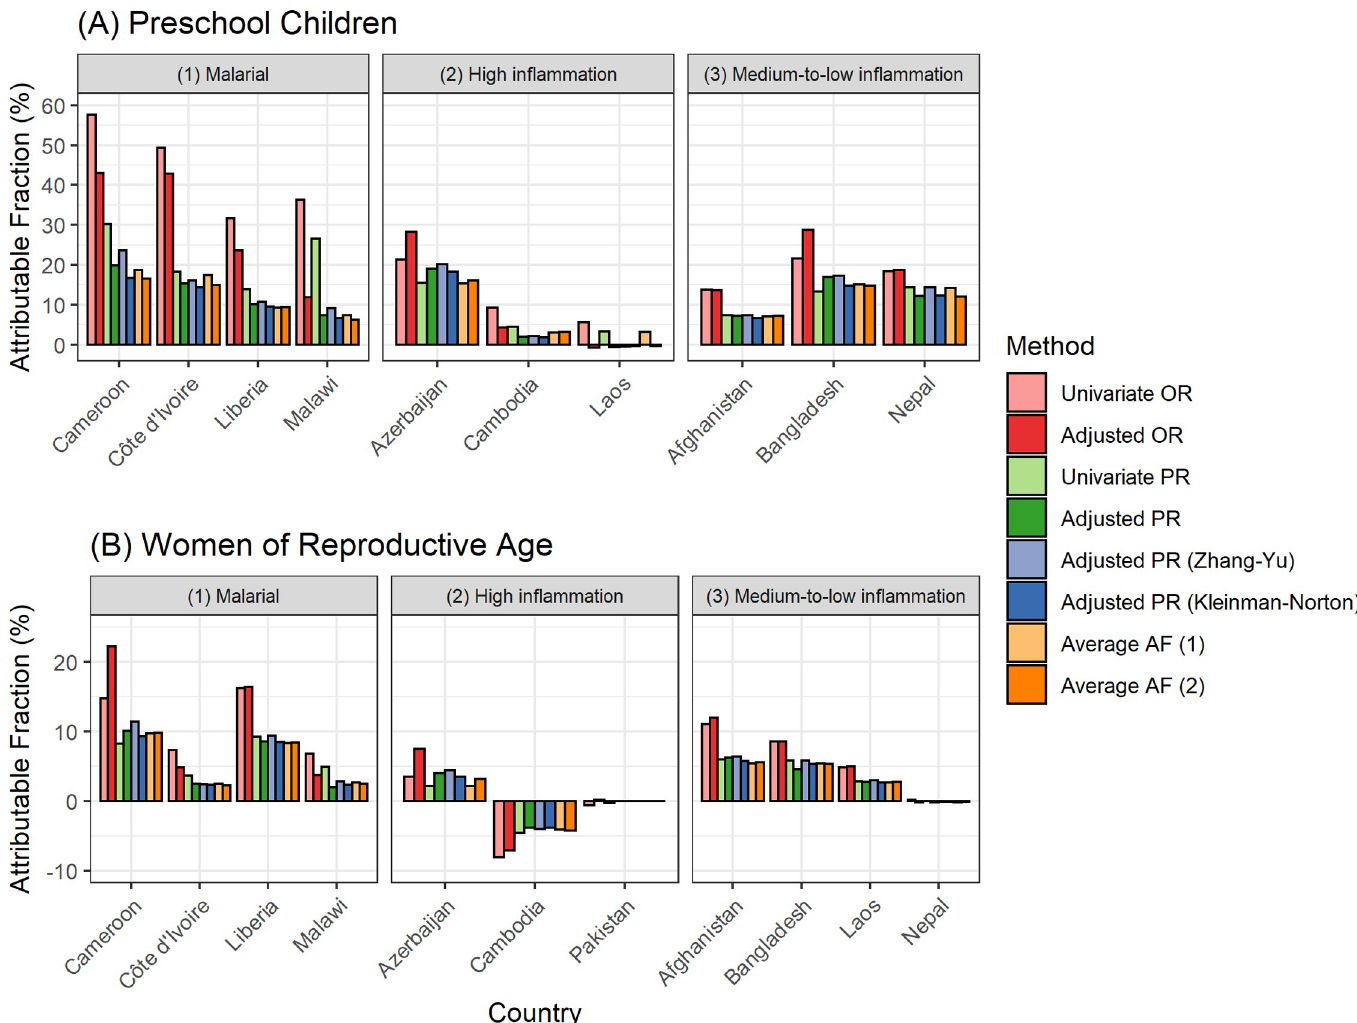
Fig 2. Estimated attributable fractions of anemia associated with inflammation in (A) preschool children and (B) women of reproductive age. Anemia defined as hemoglobin adjusted for altitude < 11.0 g/dL for children and hemoglobin adjusted for altitude and smoking < 12.0 g/dL for women. Inflammation defined as either CRP > 5 mg/L or AGP > 1 g/dL. Average AF (attributable fractions) (1) considers all exposure variables including malaria, blood disorder, and micronutrient deficiencies depending on data availability. Average AF (2) considers all exposure variables and adjusts for age, sex (for children), and SES. Covariates for adjusted OR and adjusted PR included all available exposure variables, age, sex (for children), and